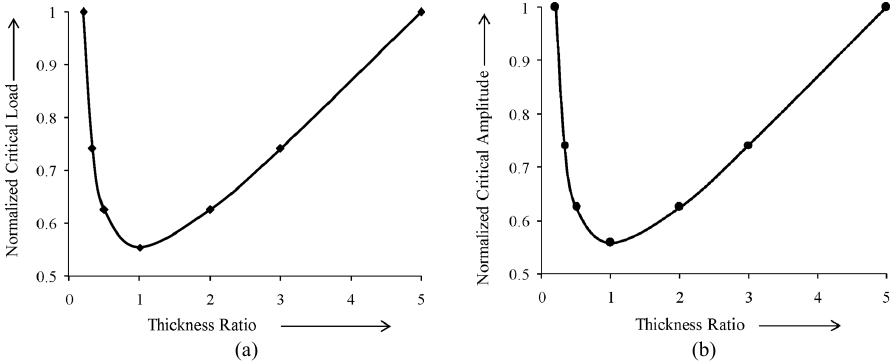
Fig. 6. (a) Variation of normalized critical load with thickness ratio for welded cantilever beams; (b) Variation of normalized critical amplitude with thickness ratio for welded cantilever beams.